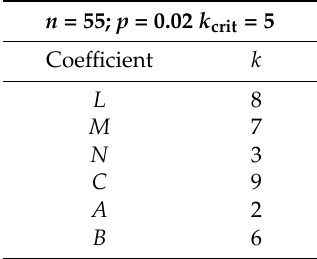
Table 2. Observed values of k considering all eleven pressure